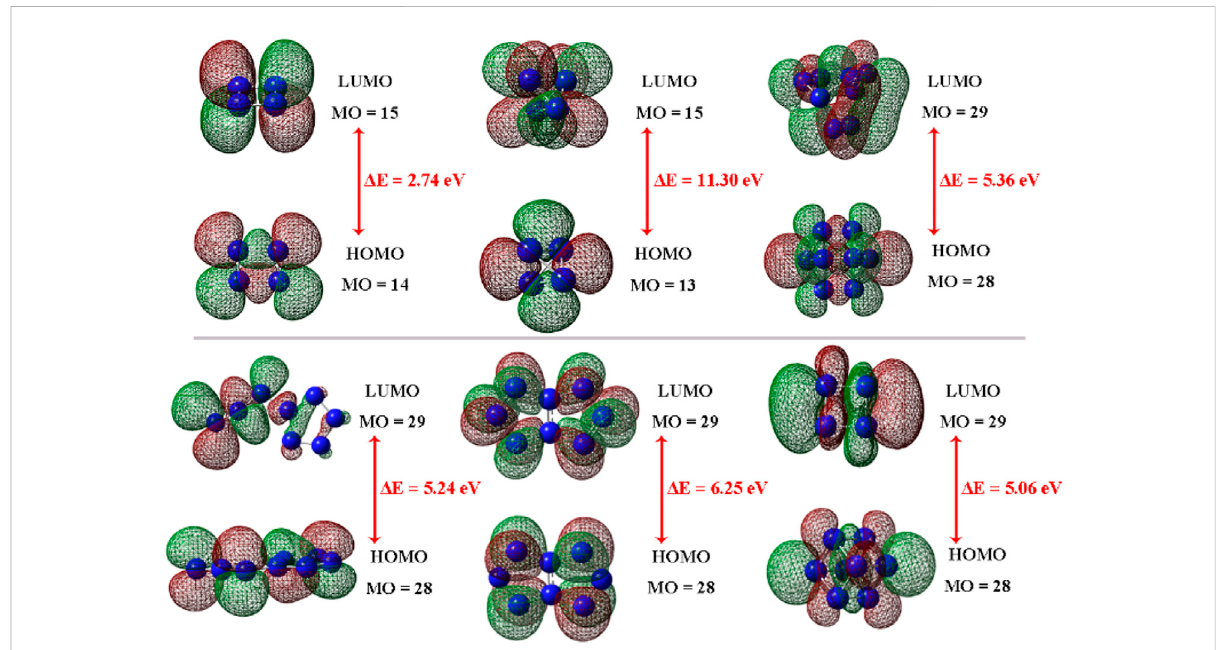
FIGURE 6 HOMO-LUMO energy levels and energy gaps of N 4 -1, N 4 -2, N 8 -1, N 8 -2, N 8 -3, and N 8 -4, respectively.